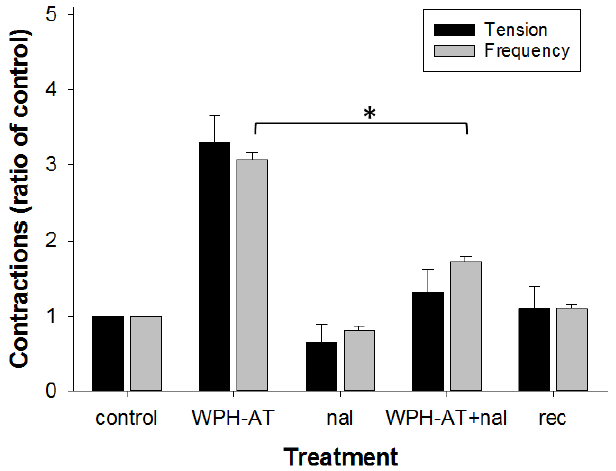
Figure 4. Effect of an opioid antagonist on the WPH-induced response in the rat distal colon. The effect of 1 µ M naloxone (nal) on the WPH-AT-induced increase in contractile tension and frequency is shown as a ratio of the pretreatment control where treatments were applied consecutively to each preparation, averaged over the preceding 10 min of a 15 min application. ( n = 3). Data show mean ± SEM. Asterisk indicates significance difference (* p < 0.05).